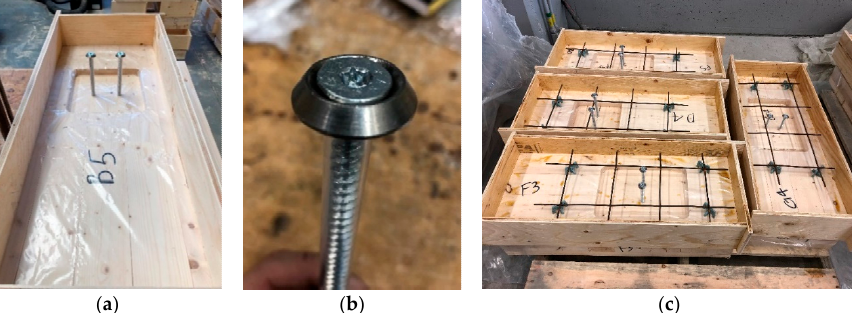
Figure 1. Specimen with preinstalled polyethylene film ( a ), vertical attachment part with a